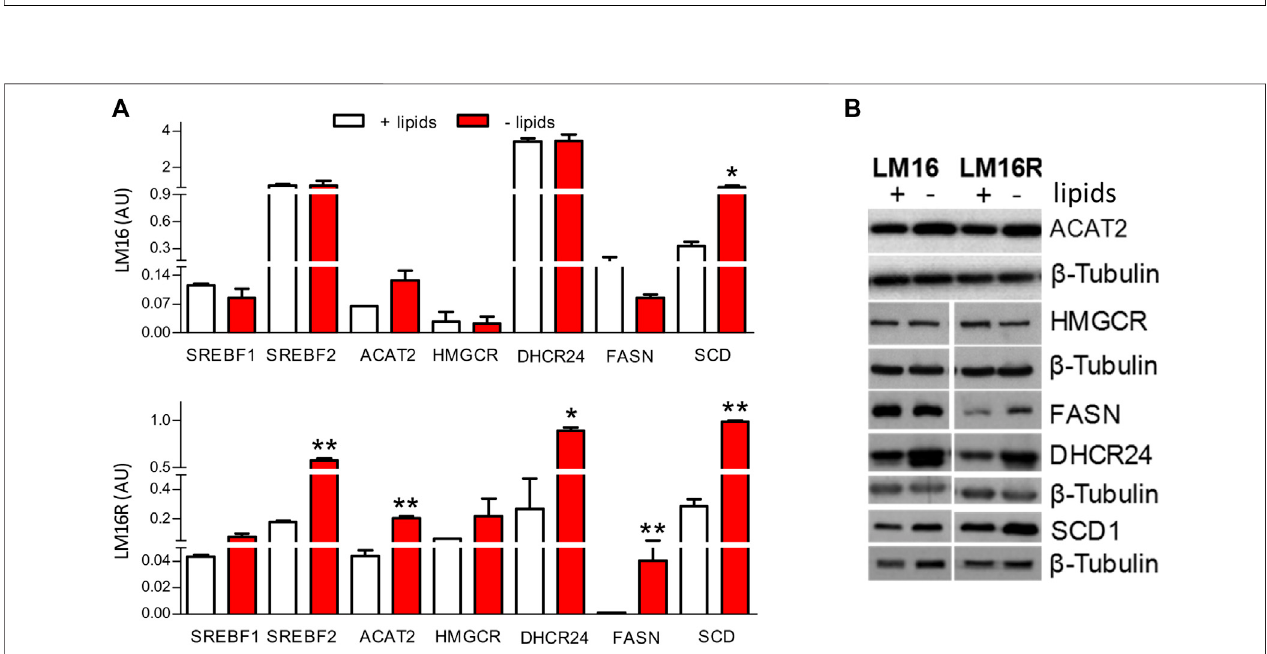
FIGURE 4 | Effects of lipid starvation on cholesterol and fatty acid synthesis pathways in LM16 and LM16R cell lines. (A) . Expression of lipid metabolism-related genes evaluated by qRT-PCR in standard and lipid-free condition. AU, Arbitrary Units. * p < 0.05; ** p < 0.01 by unpaired Student ’ s t test. (B) . Expression of lipid metabolism-related enzymes as evaluated by western blot upon lipid starvation for 48 h β -tubulin was used as loading control. Determinations were repeated two/ three times.